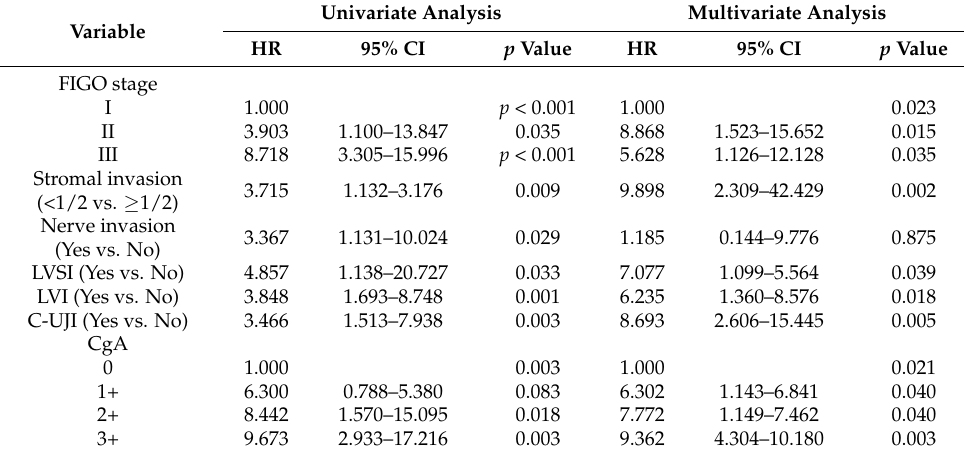
Table 2. The univariate and multivariate COX regression analysis used to screen the risk factors